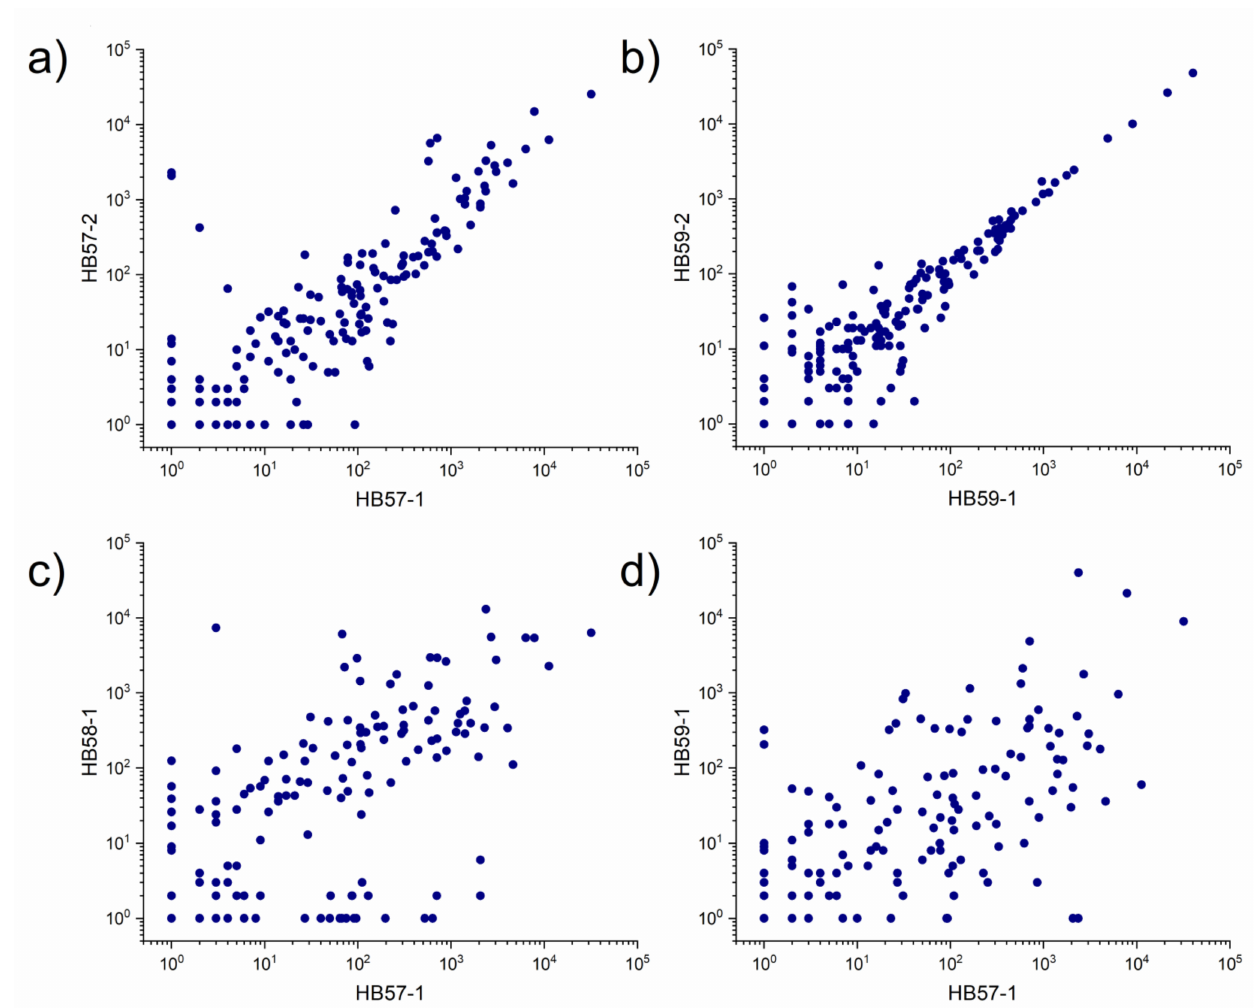
Figure 7. Correlation diagrams of OTU abundances for selected pairs of samples. ( a ) correlation of the both coal seam samples HB57-1 and HB57-2, ( b ) correlation of the both samples of bright sediment HB58-1 and HB58-2, ( c ) correlation between the coal seam sample HB57-1 and the bright sediment sample HB58-1, ( d ) correlation between the coal seam sample HB57-1 and the top soil sample HB59-1. The samples from the bright sediment are dominated by Nitrosotaleaceae , with 13,055 (HB58-1) and 16,719 reads (HB58-2) corresponding to 14% and 10% of all reads, respectively (Figure 8b). The Gammaproteobacteria group KF-JG30-C25 represented 6.8% and 5.9% of all reads, respectively. The topsoil was dominated by Nitrosotaleaceae and Acidobacteria subgroup 2. Sample HB59-1 yielded 40,207 reads of Nitrosotaleaceae (41% of total reads), and HB59-2 yielded 47,902 reads (41% of total reads). This OTU is probably related to a group